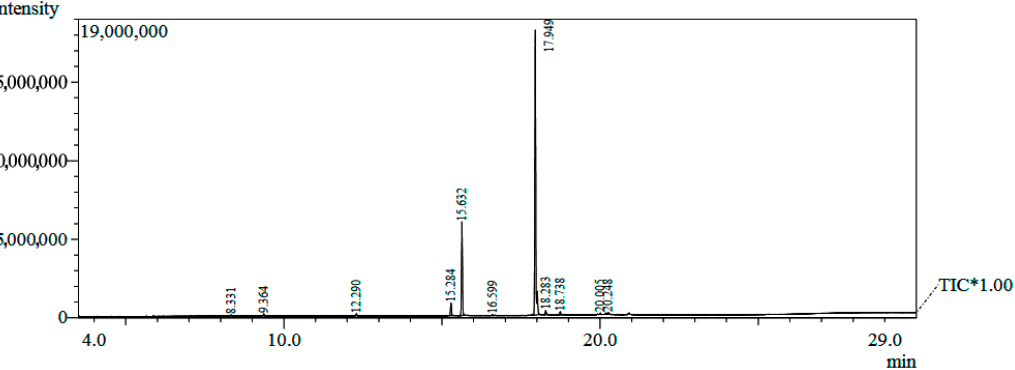
Figure 1. Chromatogram of the GC/MS analysis of Hancornia speciosa seed fixed oil. TIC* - total ion chromatograms